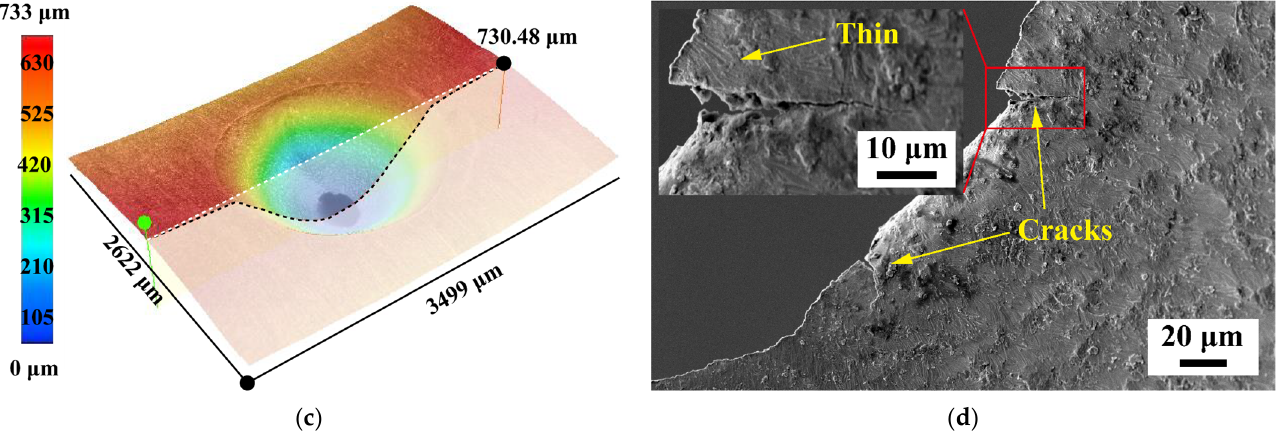
Figure 15. Wear of the impact block and the alloy tube after being cyclically impacted by Zr−4 impact block 2,000,000 times. ( a ) Worn and perforated; ( b ) wear of impact block; ( c ) 3D topography; ( d ) crack propagation.